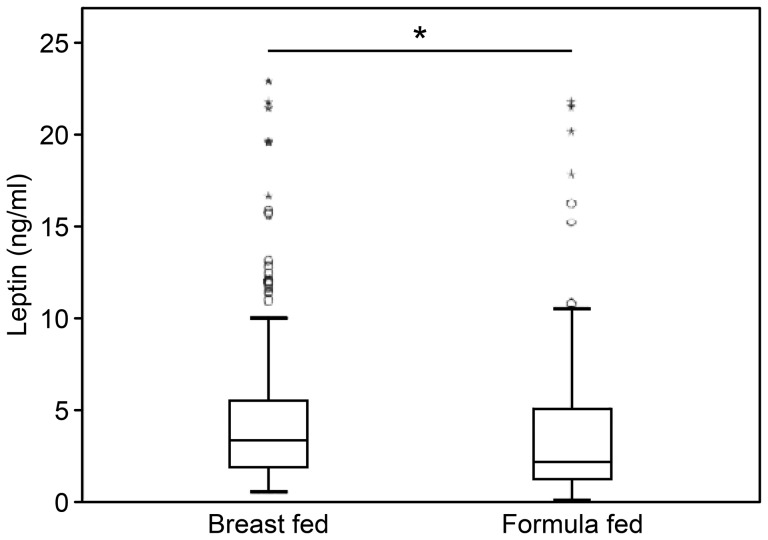
Comparison of serum leptin values in breastfed and formula-fed infants younger than 6 months of age (n = 202).The median (IQR) leptin concentration was 3.37 (3.56) ng/ml in the exclusively BF infants (n = 121) and 2.2 (3.75) ng/ml in the exclusively FF infants (n = 81); the difference between the two groups was statistically significant (* p<0.05). (Source: self-elaborated).